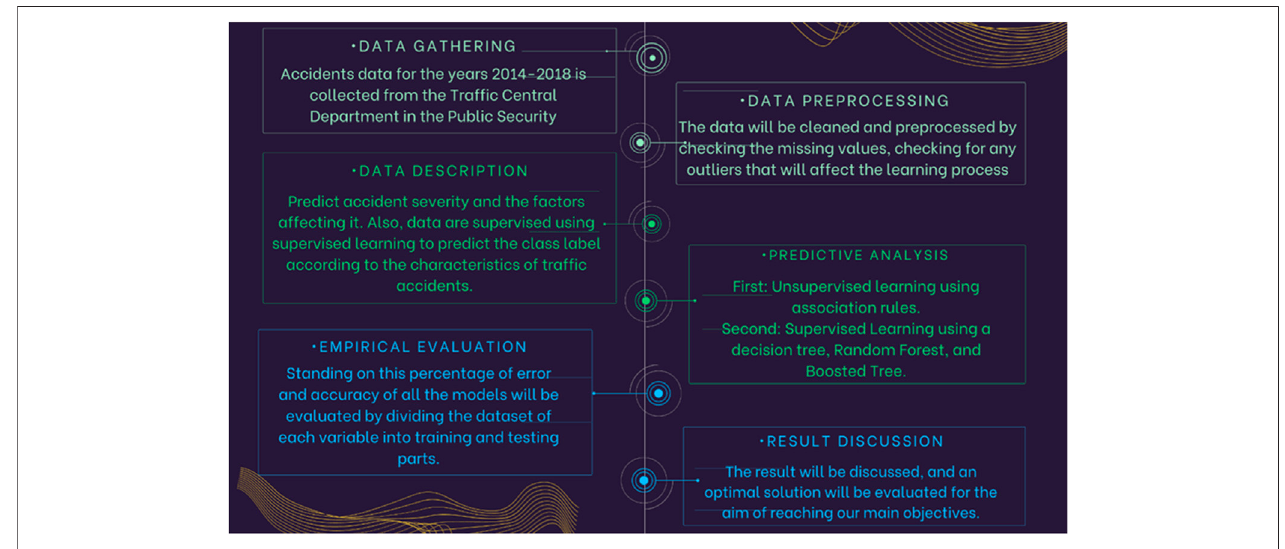
FIGURE 2 | Research